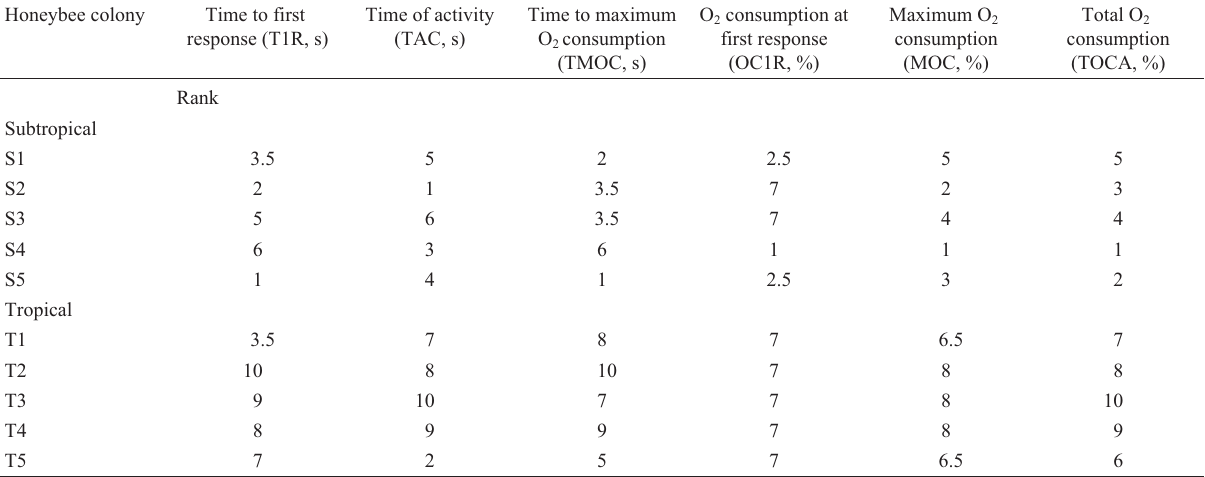
Table II - Ranking for response time and oxygen consumption for honeybee colonies from subtropical and temperate climates. Honeybee colony